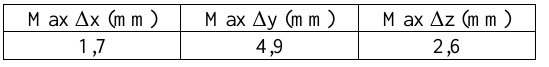
Table 3b. Coordinate change for other models according to the